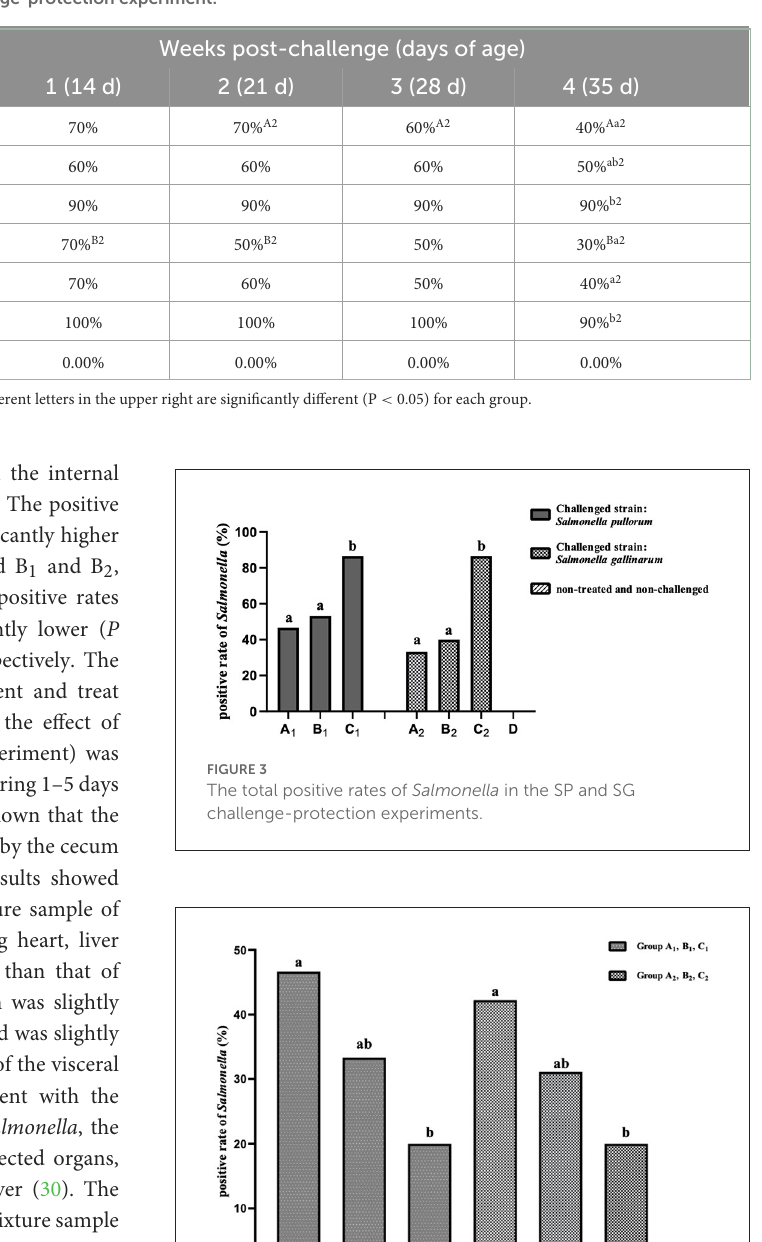
TABLE 2 PAT 1 positive rate of each group in the challenge-protection experiment.